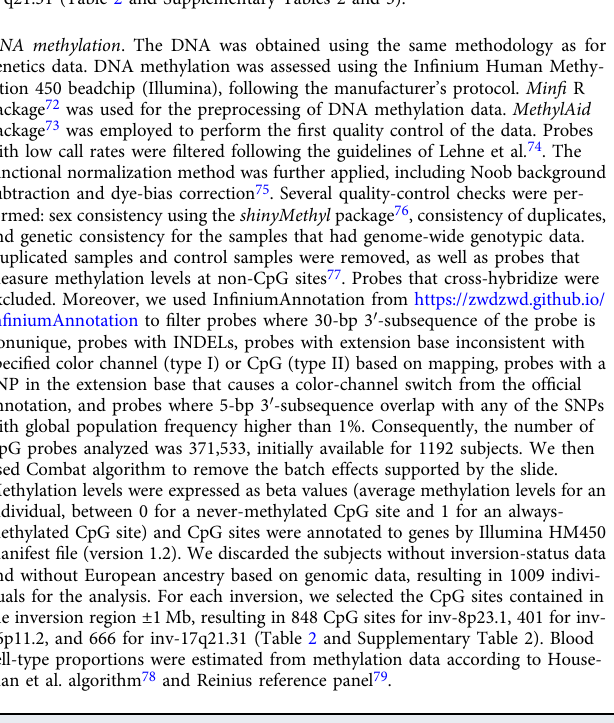
Table 2 Characteristics of HELIX data relating 3 common polymorphic inversions in